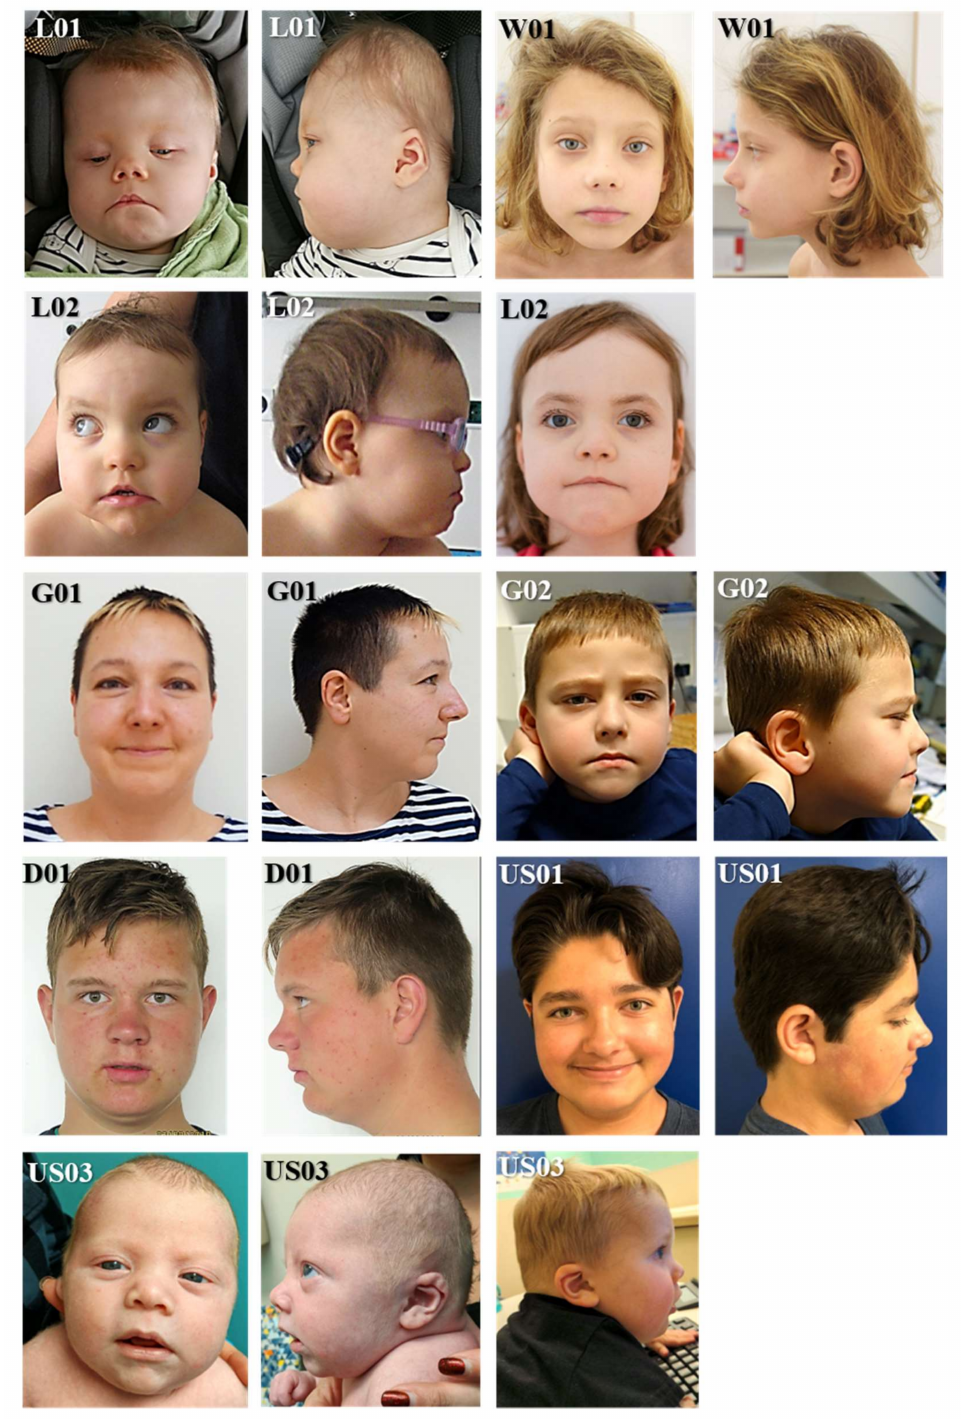
Figure 1. Pictures of POGZ patients enrolled in the present study. Patient L01 at the age of 11 months, W01: at the age of 9 years, L02: at the age of 1 year and 4 years, G01: at the age of 35 years, G02: at the age of 5 years, D01: at the age of 17 years, US01: at the age of 14 years, US03: in infancy and at the age of 2.5